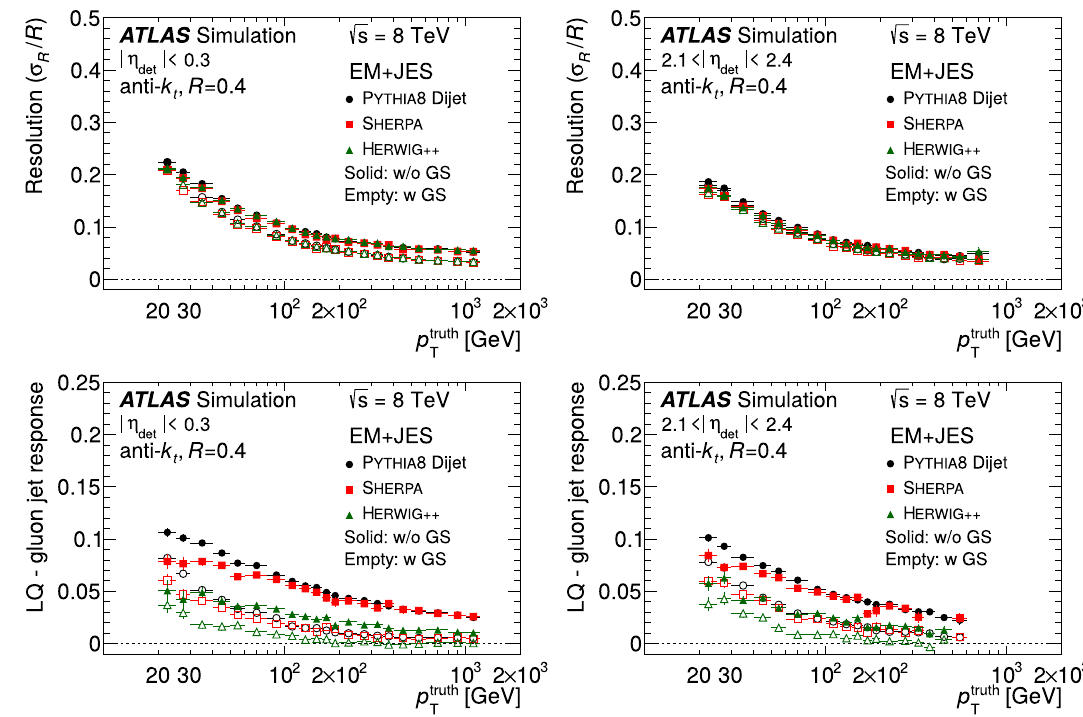
Sherpa (squares), and Herwig++ (triangles) dijet MC samples. All jets are reconstructed with anti- k t R = 0 . 4. Jets are labelled LQ- or T gluon-initiated, based on the highest-energy parton in the MC event record which fulfils an angular matching to the jet as further detailed in Sect.